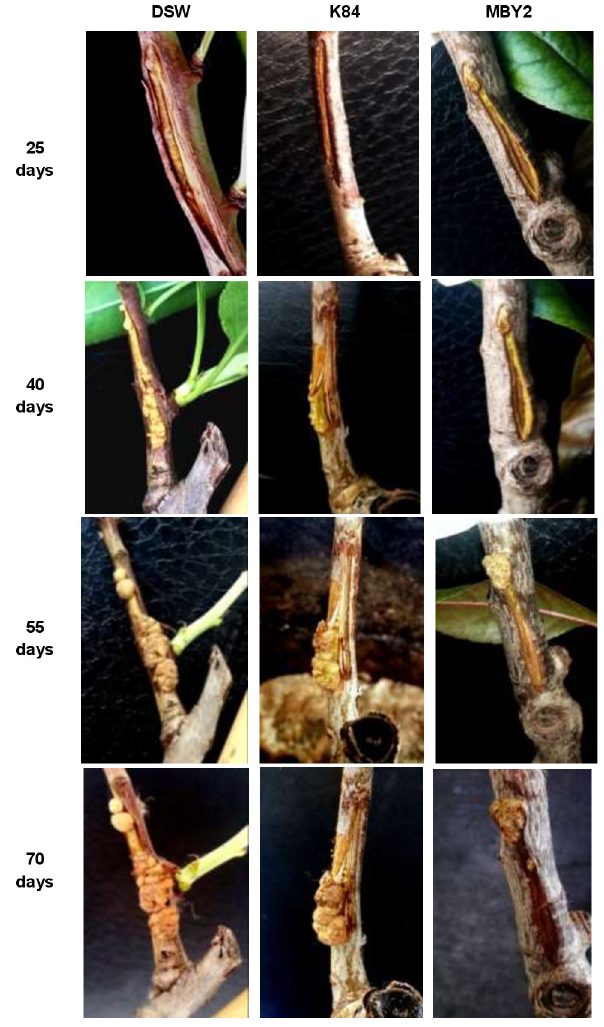
Fig 6. Antagonistic activity in planta of B . velezensi s MBY2 on almond trees. Stems of almond ( Prunus amygdalus var Mazzetto/GF) trees were pre-infected with A . fabrum C58 and subsequently treated with B . velezensis isolate MBY2, with A . radiobacter biocontrol strain K84 as positive or with distilled sterile water (DSW) as negative control. Tumor proliferation was followed for up to 70 days post-inoculation. For each treatment three plants were used in one representative